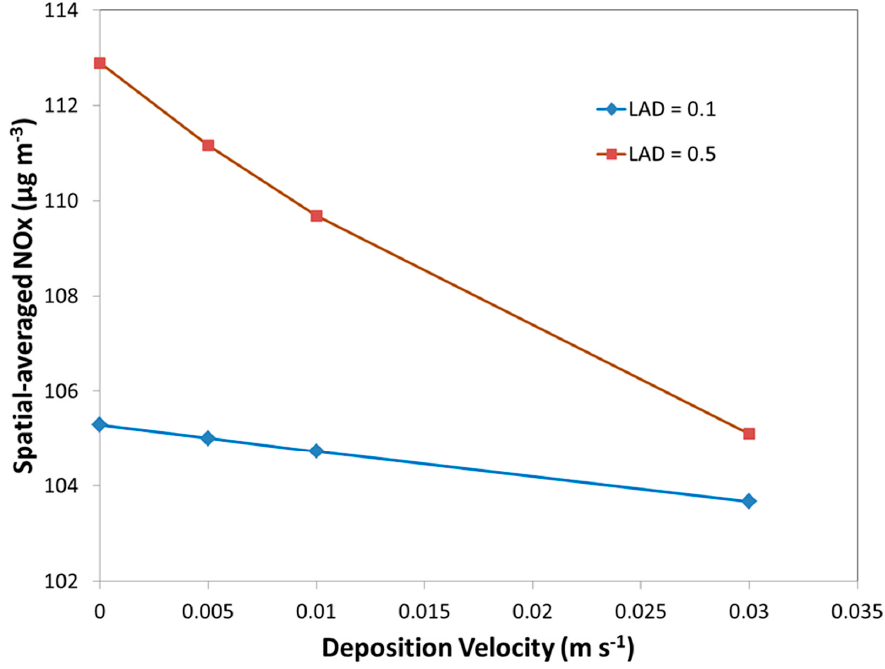
Figure 7. Variation of spatial-averaged concentrations in the neighborhood with deposition velocity for real-tree and evergreen-tree cases.